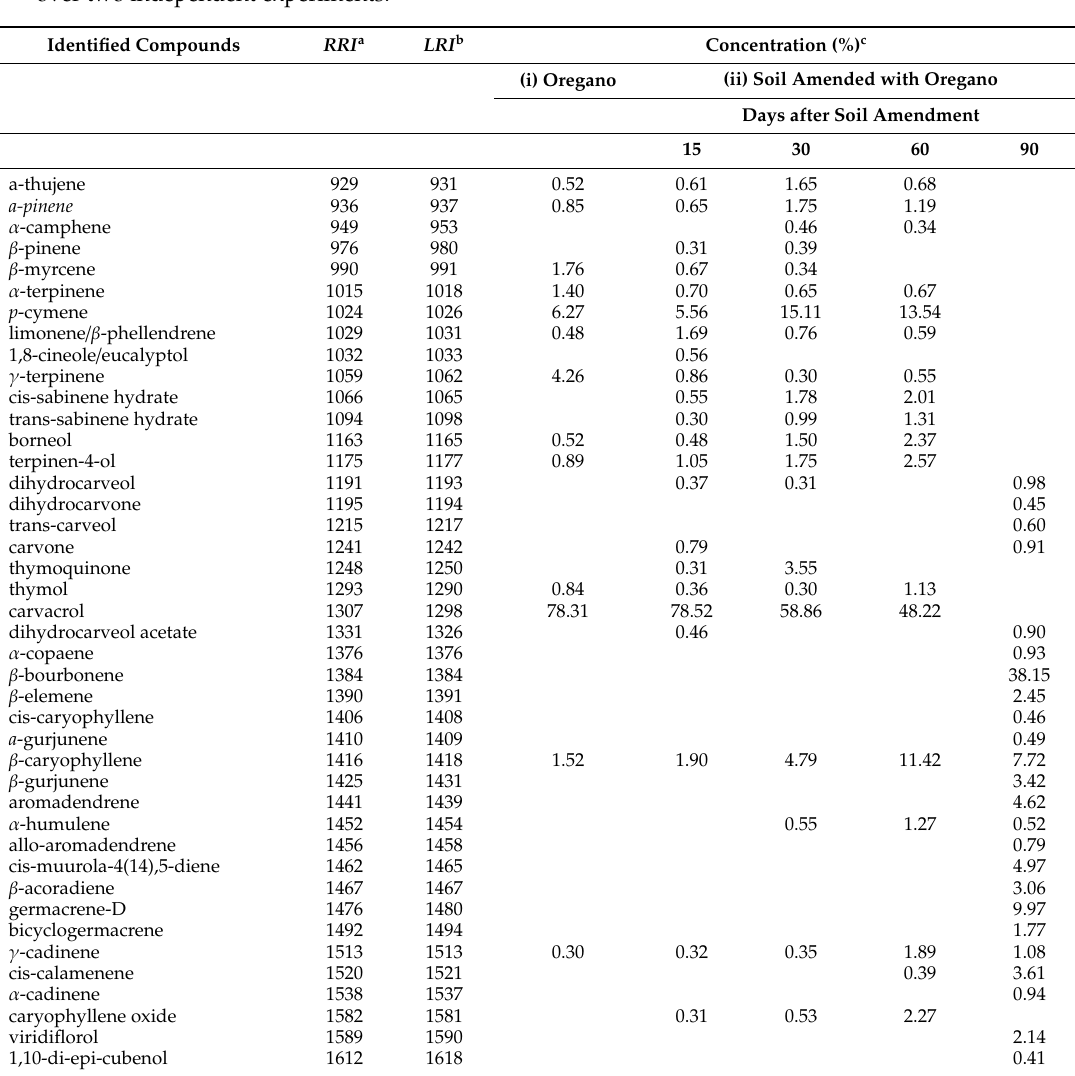
Table 4. Qualitative and quantitative analysis of volatiles present (i) in oregano plant material, and (ii) in soil samples taken at di ff erent times after amendment with 4% (w / w) oregano tissue. Data averaged over two independent